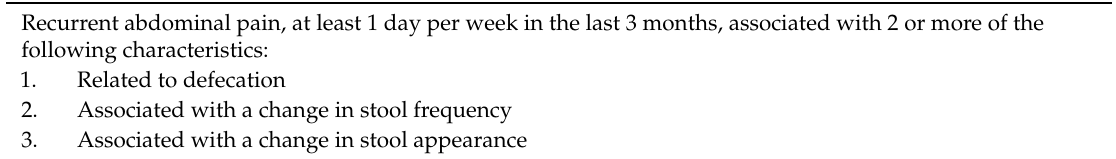
Table 1. Rome IV diagnostic criteria for irritable bowel syndrome